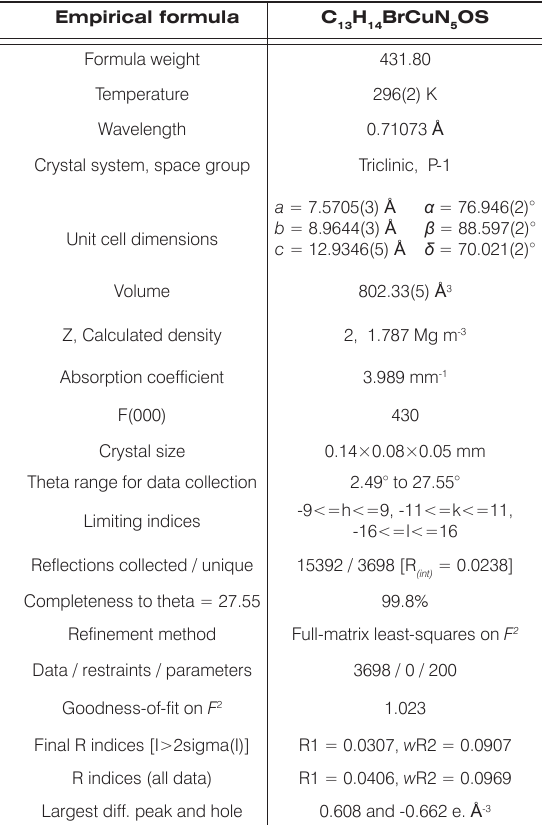
Table 1. Crystal data and structure refinement for Cu(II)-complex. Empirical